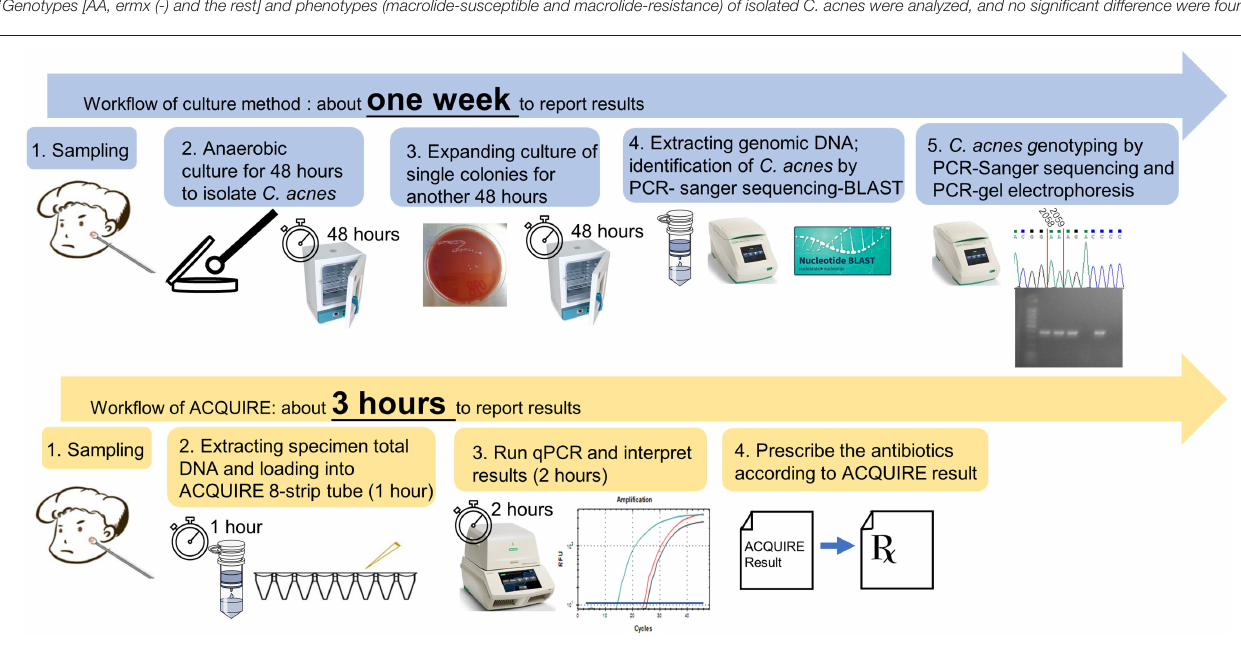
FIGURE 3 | Comparison of the workflow and time-cost between the current method and proposed